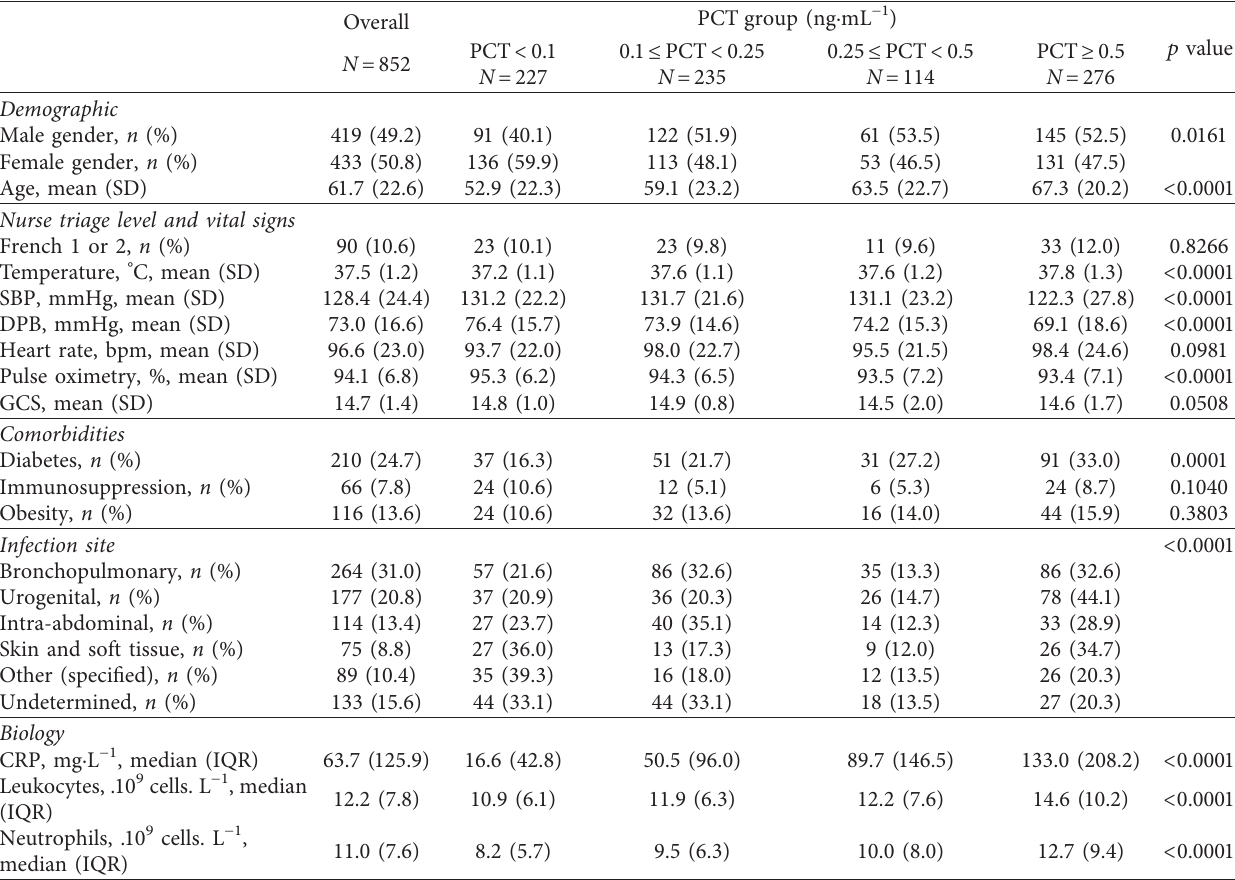
Table 1: Patient characteristics stratified by PCT group.